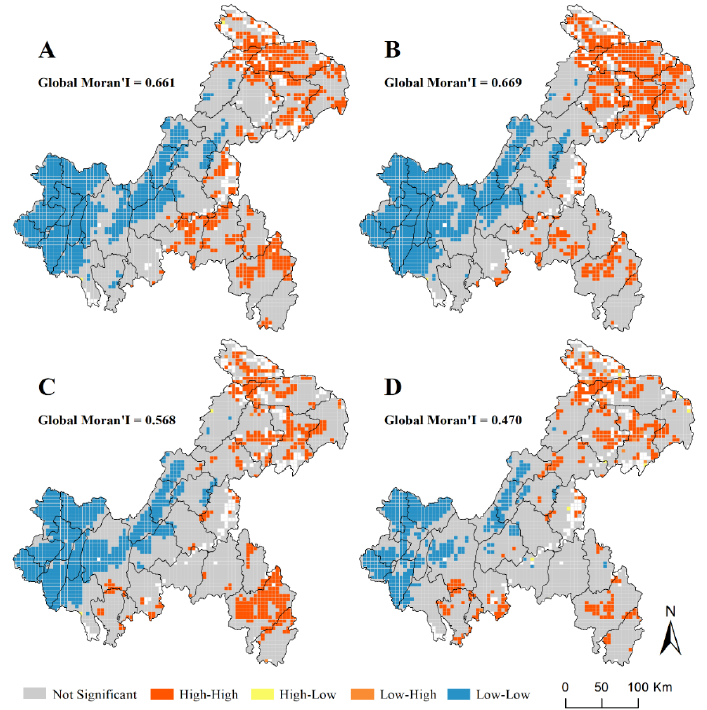
Figure 7. Spatial clustering types within 5 km grid squares in Chongqing ( A ) between 2001 and 2005, ( B ) between 2006 and 2010, ( C ) between 2011 and 2015, and ( D ) between 2016 and 2020. ment from 2001 to 2020 (Figure 8). Oscillating, diminishing, sporadic, and persistent cold